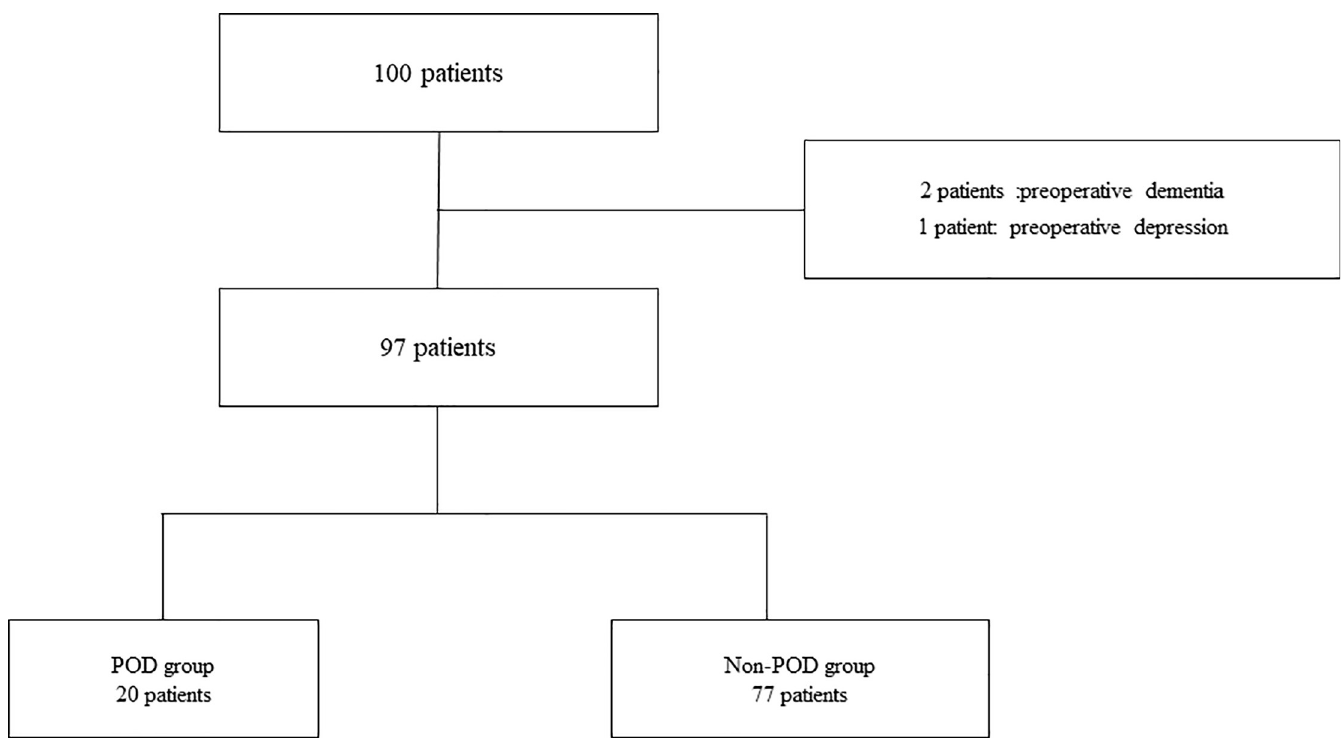
Fig 1. Study population flowchart. POD: Postoperative delirium.